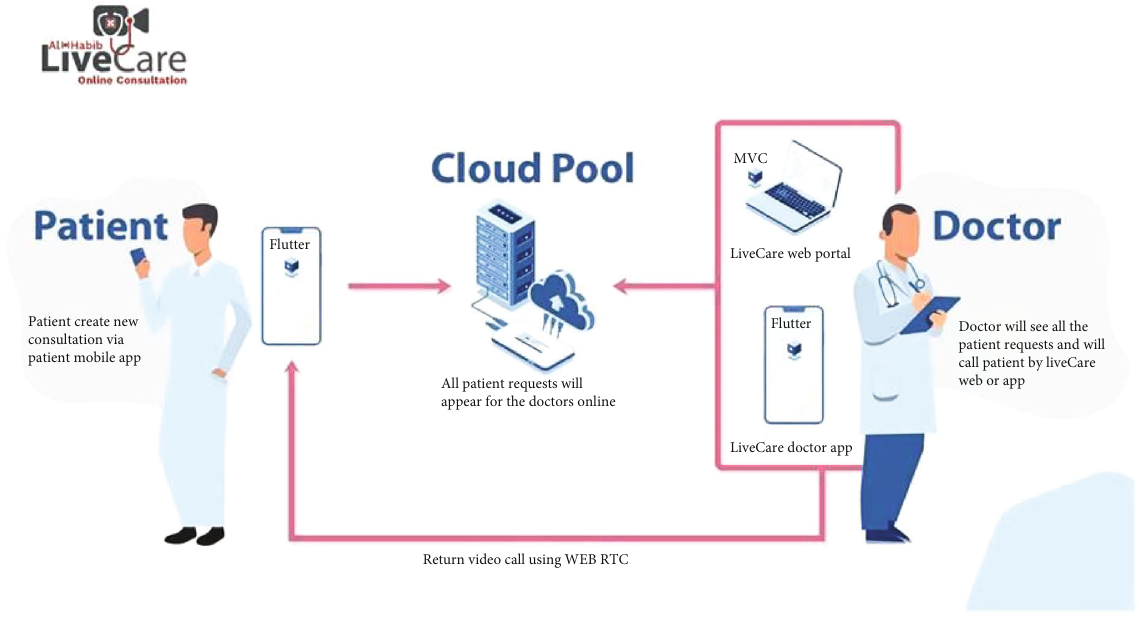
Figure 3: LiveCare (Telemedicine) platform. MVC =model view controller; RTC =real-time